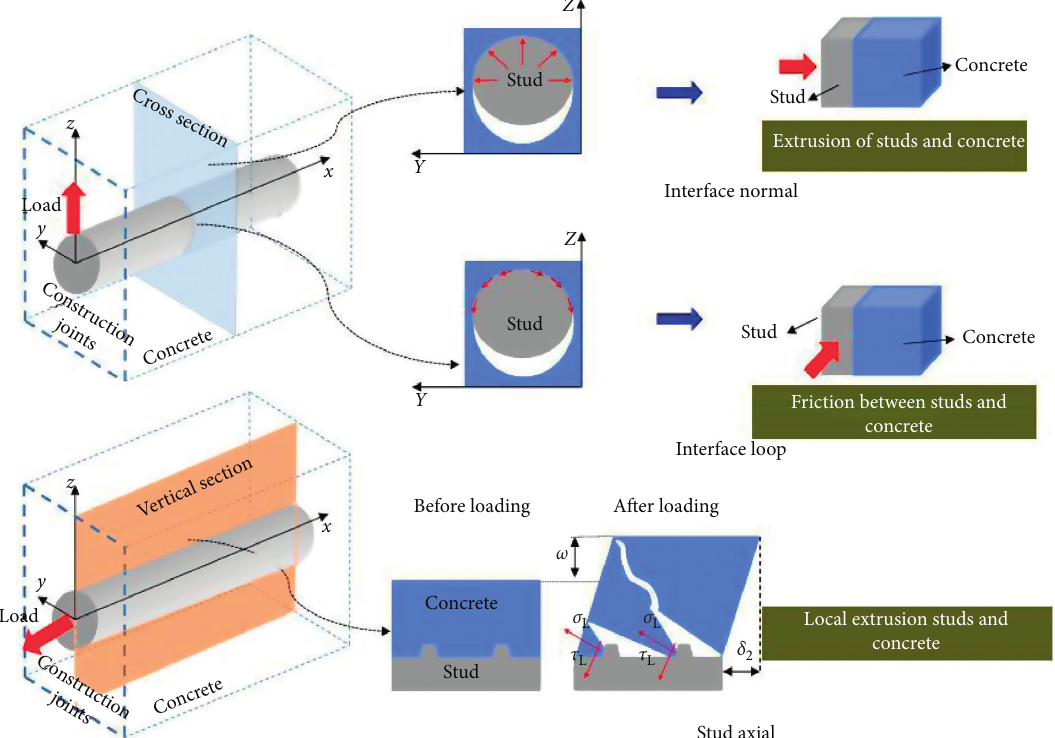
Figure 15: Three-dimensional relative motion decomposition and load transfer of